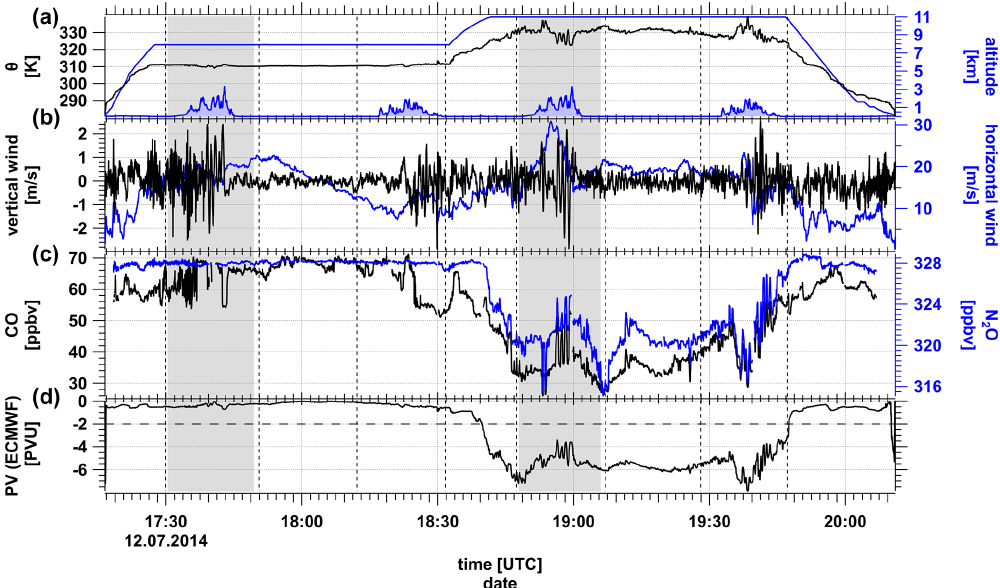
Figure 2. Time series of (a) potential temperature (cid:50) from the measurements (black), altitude (blue) above surface elevation (filled blue), (b) vertical wind (black), horizontal wind (blue), (c) N 2 O (blue) and CO (black) volume mixing ratios and (d) ECMWF potential vorticity (PV) interpolated along the flight track. Light gray boxes indicated the tropospheric and stratospheric flight section for the detailed mixing analysis. Vertical dashed lines mark turning points of the aircraft. Surface elevation was interpolated from SRTM15+ data (Tozer et al., 2019).